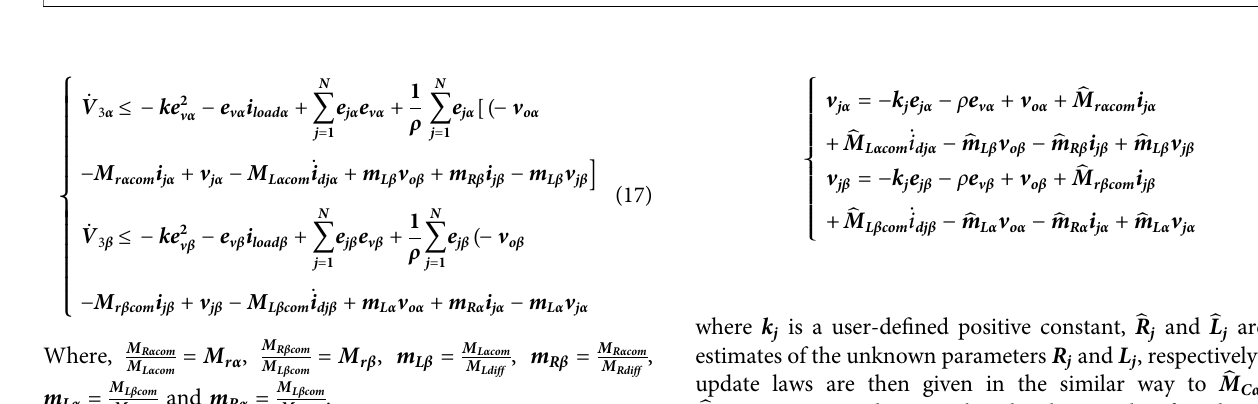
FIGURE5| Three-phasesimulationresultsbyusingproposedcontrolincludingscenariosof1)startup(from0to0.5 s),2)modulewithoutmismatch#1case(from 0.2 to 0.4 s), 3) module failure #2 case (from 0.4 to 0.6 s) and 4) module-mismatch #3 case.